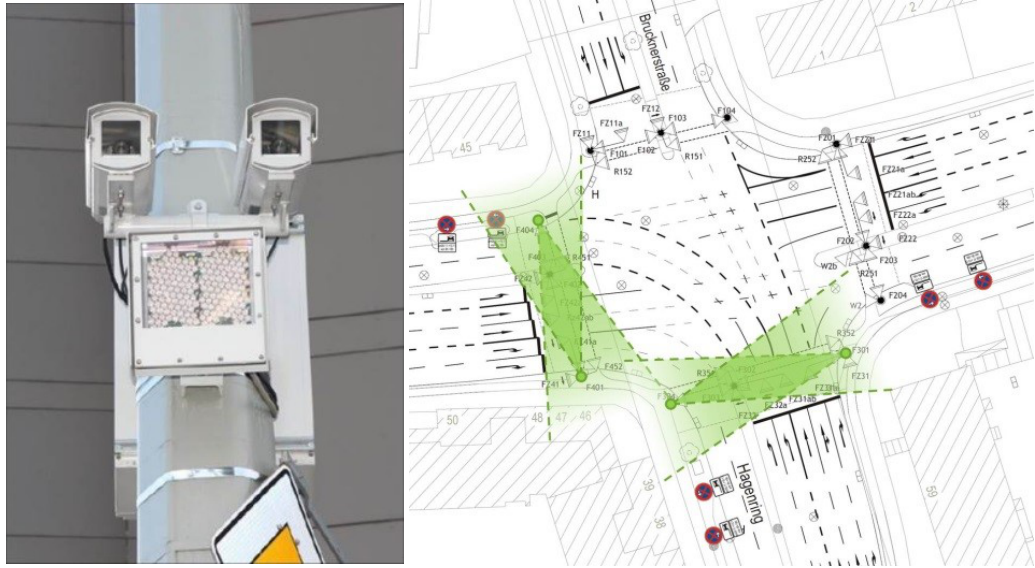
Figure 3: Single pole installation of SENV (left) and bird’s eye view of all sensor locations